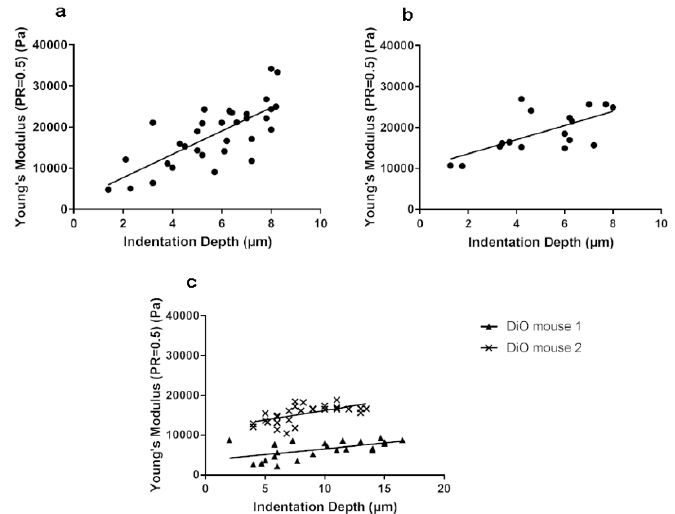
Figure 6. Corneal stromal stiffness. Young’s modulus (Pa) was determined throughout the depth of the stroma in control 8- and 15-week corneas and compared to 15-week DiO corneas. ( a ) 8-week control (R 2 = 0.5527) ( b ) 15-week control (R 2 = 0.4534) ( c ) 15-week DiO (R 2 = 0.311 for DiO mouse 1; R 2 = 0.3744 for DiO mouse 2). Both eyes were measured for each mouse.